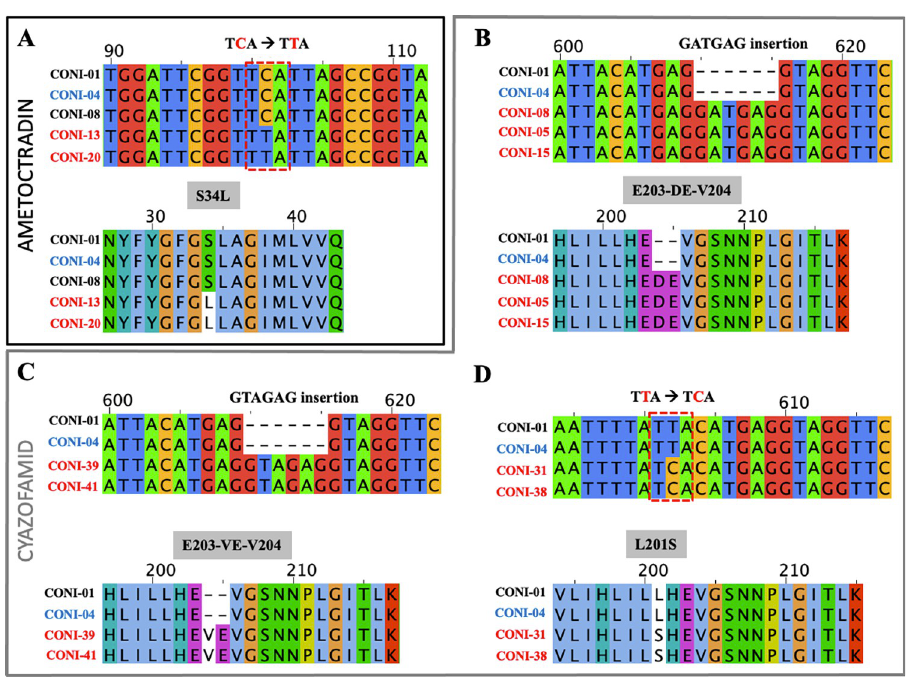
Fig 1. Alignment of cyt b partial sequences of cyazofamid and ametoctradin P . viticola resistant isolates. In black: sequence of sensitive strain. In red: sequences of strains resistant to cyazofamid or ametoctradin accordingly. In blue: AOX strain. The cyt b variations observed for the resistant isolates are non-synonymous changes or multiple 3-base insertions all leading to amino acid changes in the protein. Sequences of strains with S34L substitution (A), GATGAG insertion (B), GTAGAG insertion (C) and L201S substitution